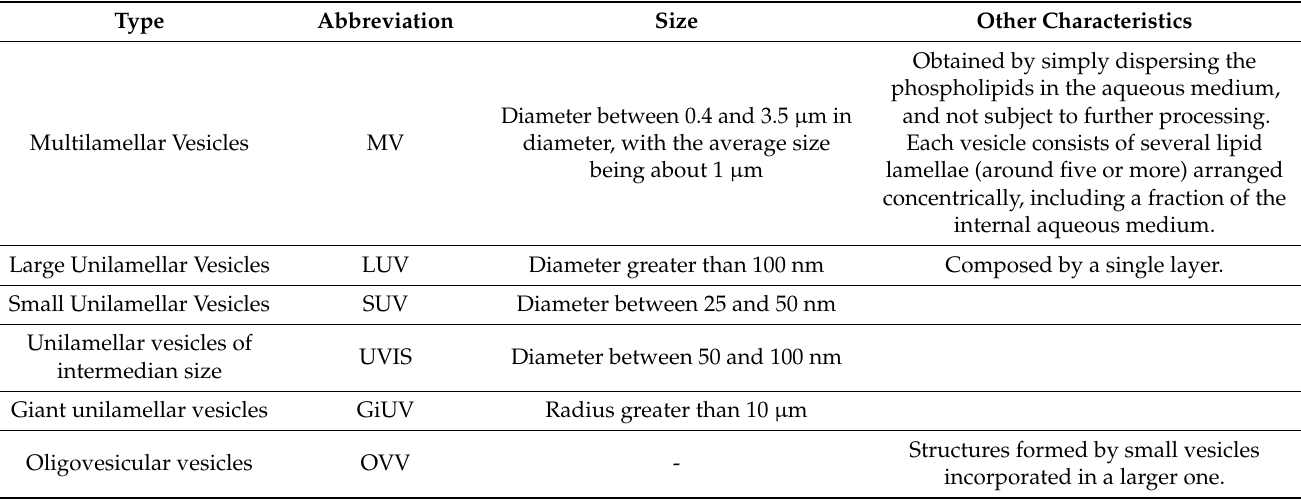
Table 1. Classification of the different types of liposomes based on their physical